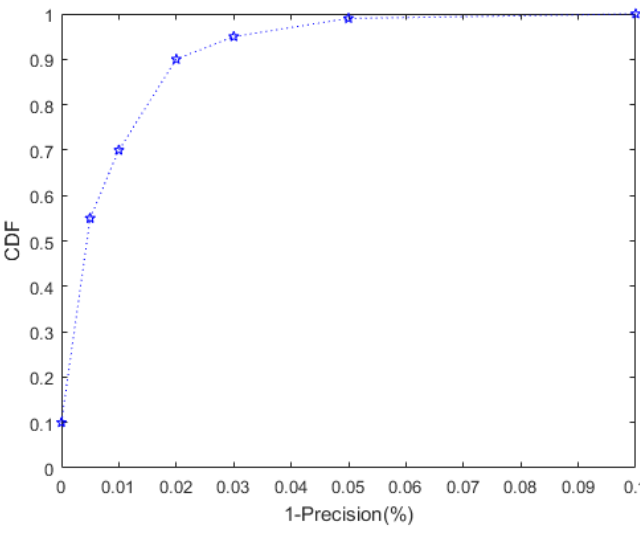
Figure 6. Detection accuracy of the clone event.